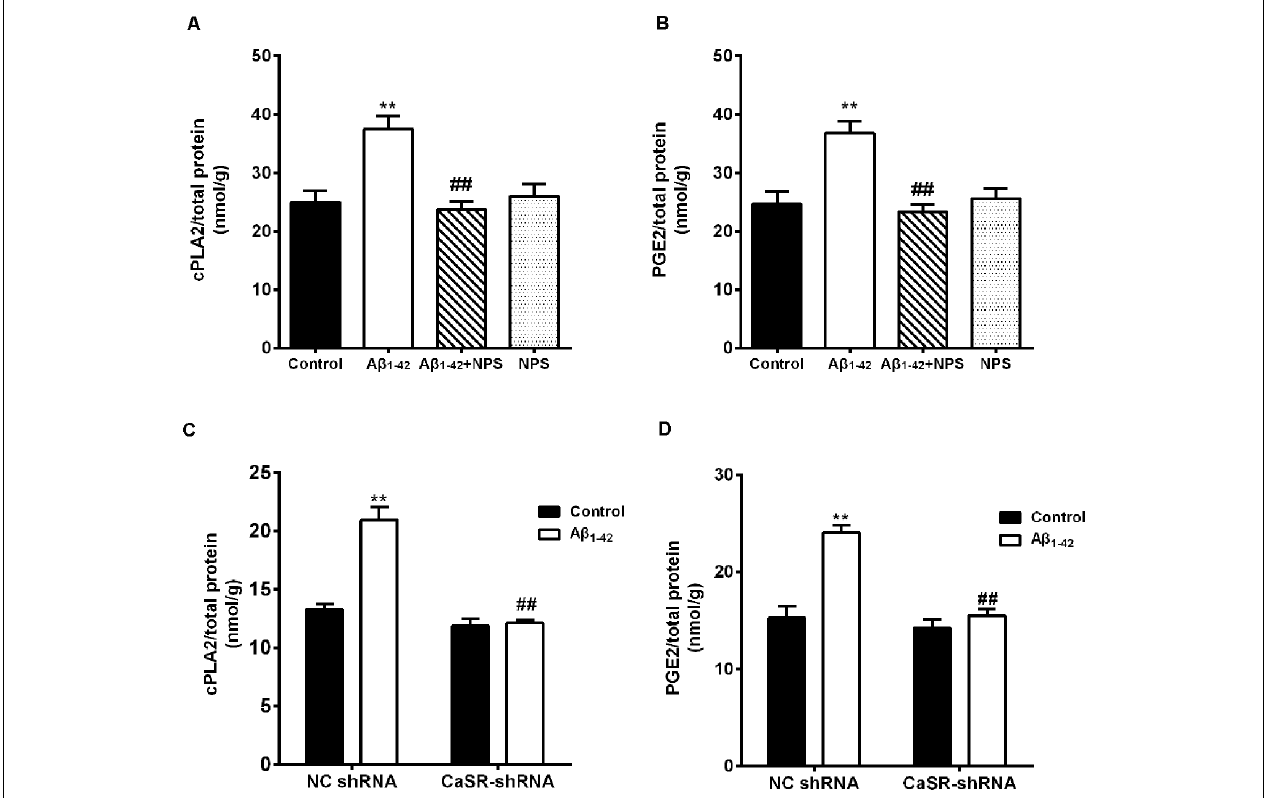
FIGURE 8 | CaSR was involved in A β 1–42 -induced increase of cytosolic phospholipase A2 (cPLA2) and prostaglandin E2 (PGE2) in hippocampal neurons. (A,B) Quantitative comparison of the contents of cPLA2 and PGE2 in the A β 1–42 —(0.5 µ M) and/or NPS 2143—(0.1 µ M) treated groups. ** P < 0.01 vs. control group, ## P < 0.01 vs. A β 1–42 oligomer-treated group. Values represent mean ± SEM, n = 12–13 independent replicates. (C,D) Quantitative comparison of the contents of cPLA2 and PGE2 in the A β 1–42 and/or CaSR-shRNA-lentivirus-treated groups. ** P < 0.01 vs. NC shRNA group. ## P < 0.01 vs. A β 1–42 + NC shRNA group, n = 9 independent replicates.